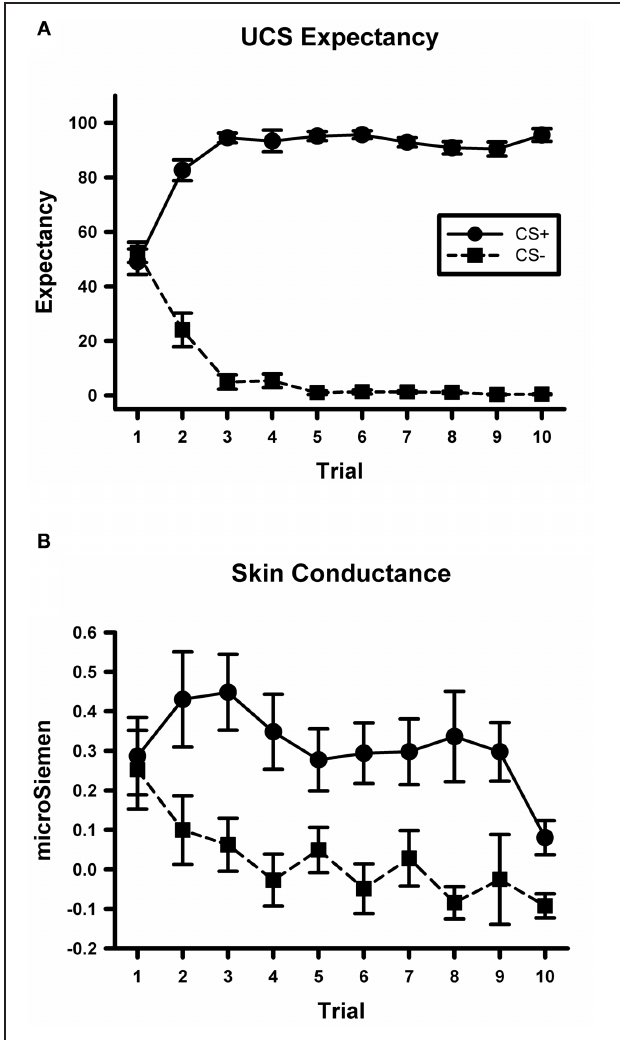
FIGURE 2 | Participants demonstrate differential conditioning with UCS expectancy ratings and SCR. (A) Mean UCS expectancy ratings on CS + and CS − trials during the conditioning task. (B) Mean SCR on CS + and CS − trials during the conditioning